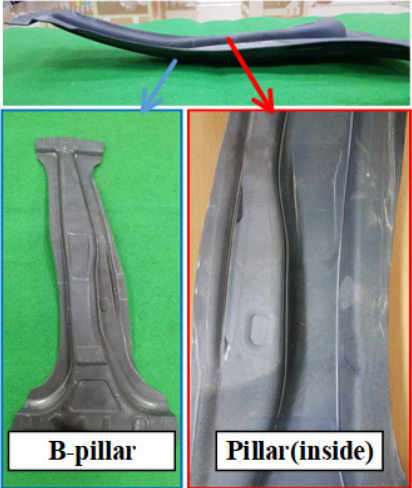
Figure 10. Manufactured B-pillar by the hot stamping process.